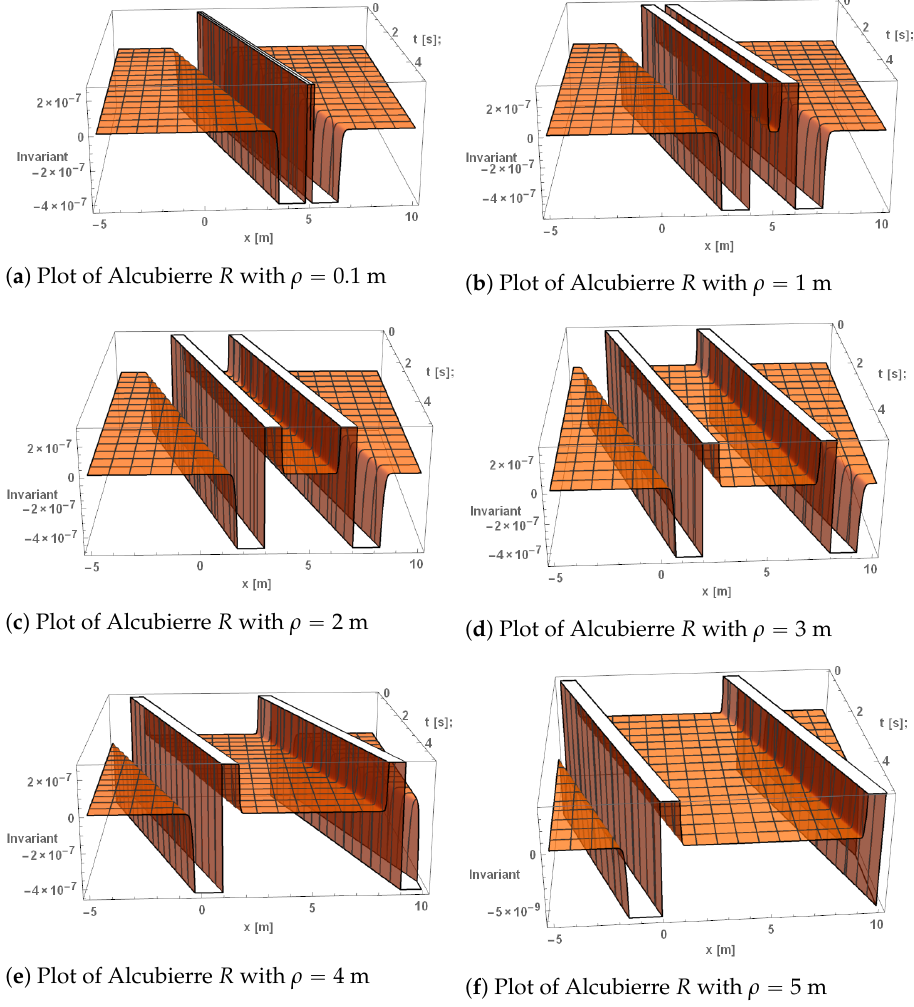
Figure 3. Plots of the R invariant for the Alcubierre warp drive while varying radius. The other parameters were chosen as σ “ 8 m ´ 1 and v s “ 1 c to match the parameters Alcubierre originally suggested in his paper